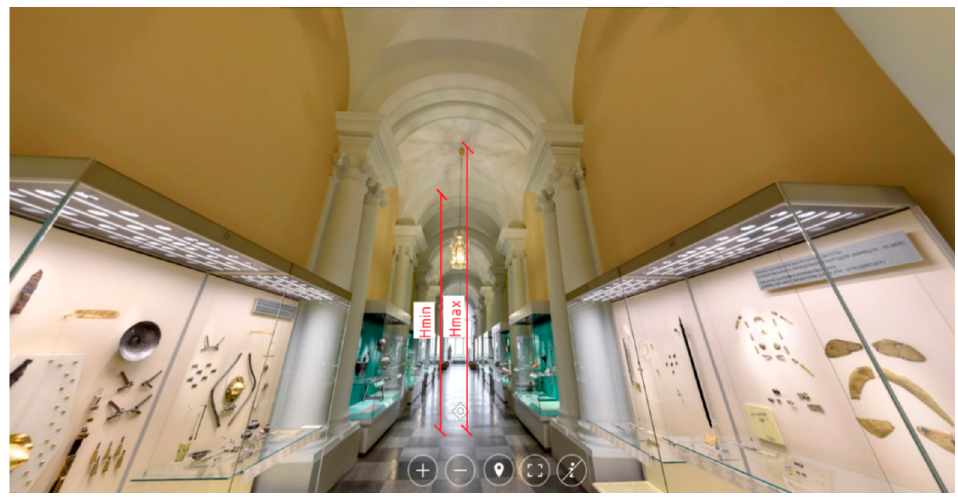
Figure 6. Bronze Age Hall on the plan of the Winter Palace ( a ); in the model ( b ).